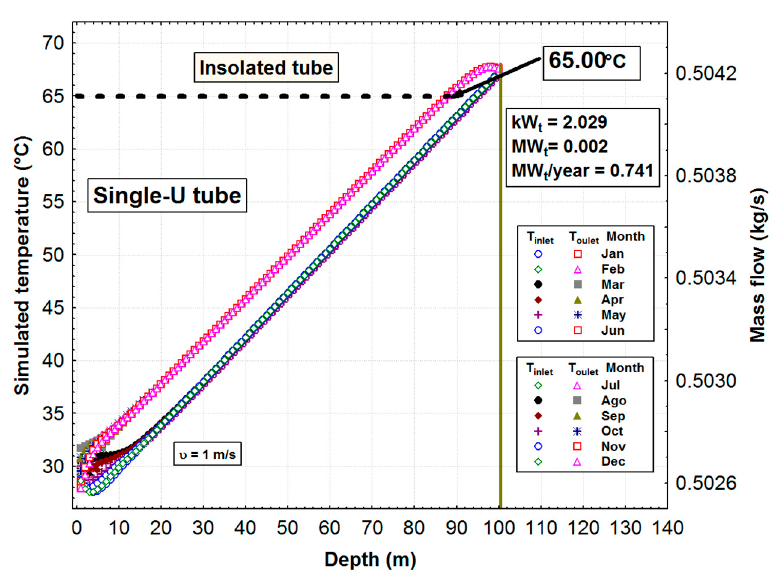
Figure 7. Temperatures simulated along the U-tube heat exchanger in well W1.